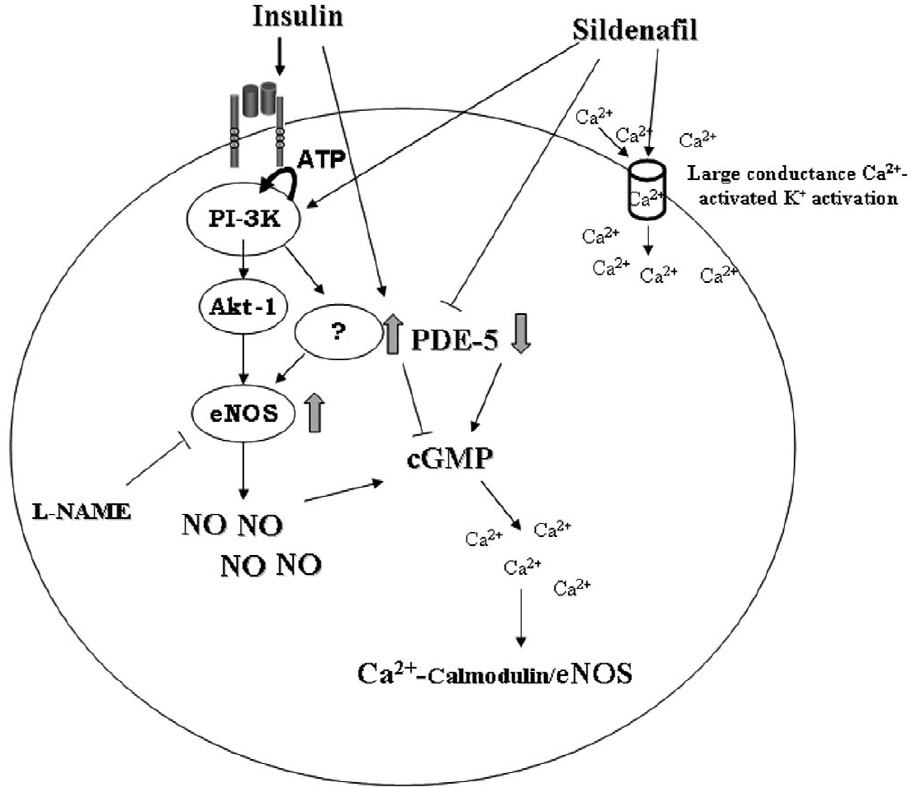
Figure 6. Schematic summary of sildenafil action in endothelial cells.